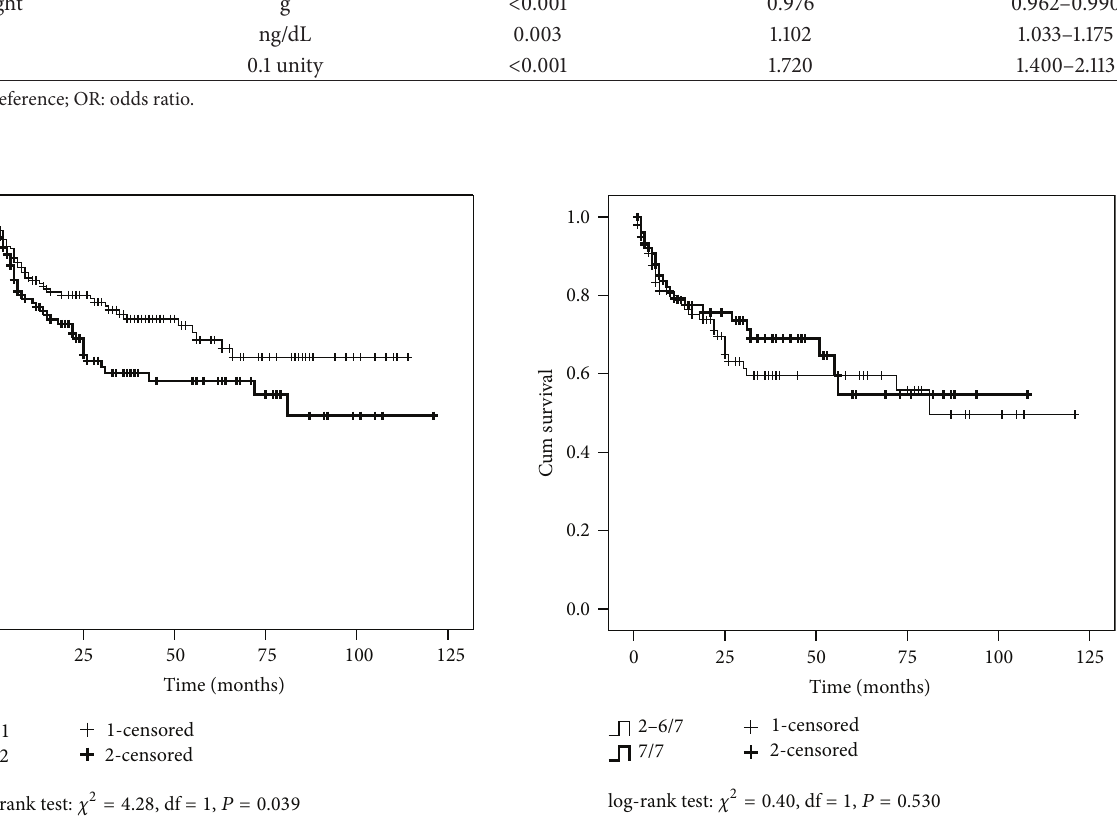
Figure 2: Disease-free survival by Gleason score between biopsy and radical prostatectomy (“2–6” to “7” versus “7” to